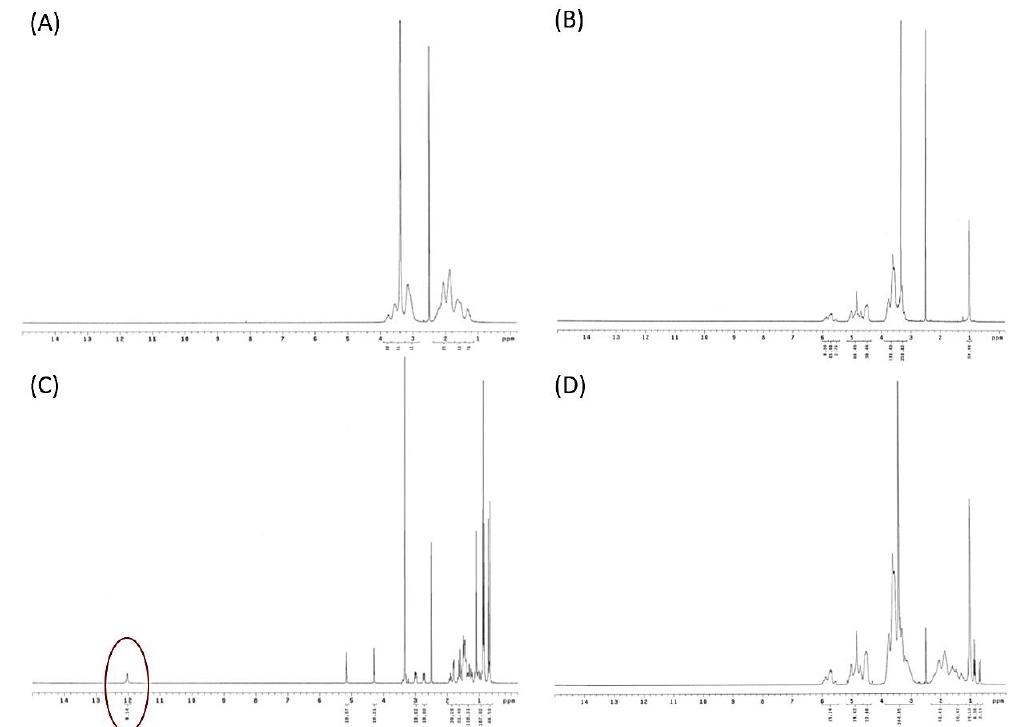
Figure 6. Nuclear Magnetic Resonance (NMR) spectra of OA and OAnf with different ratios and excipients. ( A ) HPBCD, ( B ) PVPK90, ( C ) oleanolic acid, and ( D ) OAnf (1:8:20).